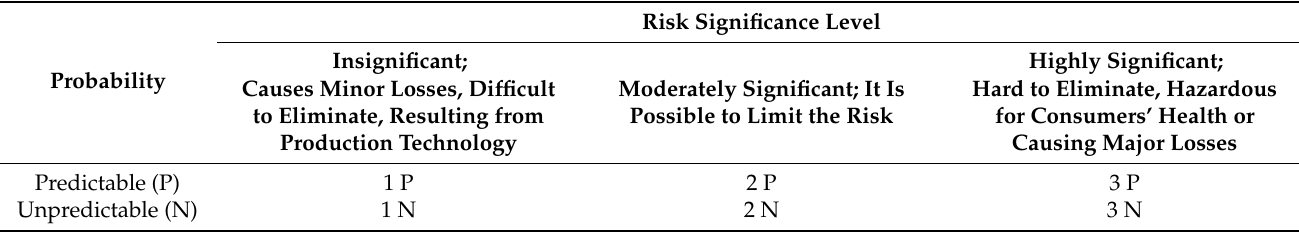
Highly Significant; Hard to Eliminate, Hazardous for Consumers’ Health or Causing Major Losses